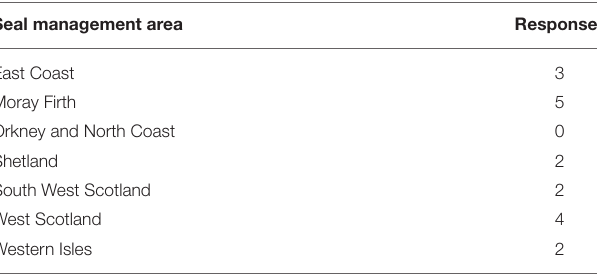
TABLE 10 | Responses to Question 12 of License Holder